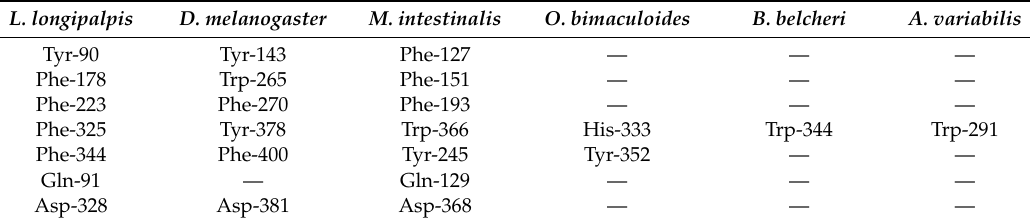
Table 2. Residue correspondence between L. longipalpis LJM11 and the DCE/ yellow proteins of D. melanogaster , M. intestinalis , O. bimaculoides , B. belcheri and A. variabilis .